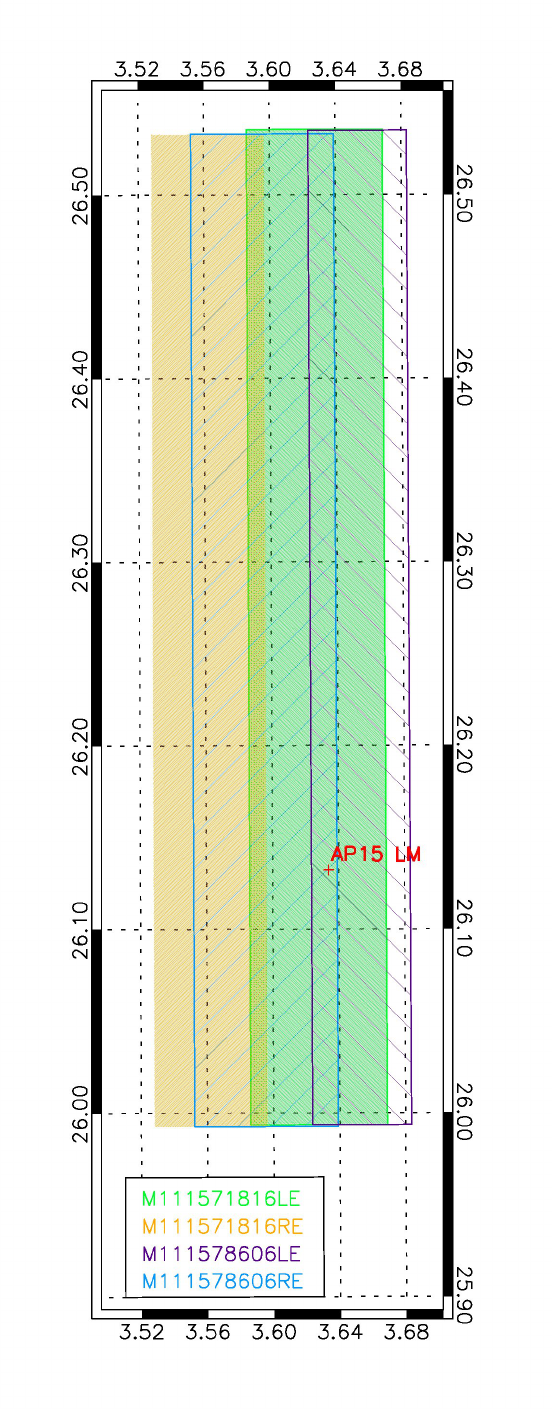
Figure 7: Image overlap of the Apollo 15 landing site area for images obtained during LRO orbits 1576 and